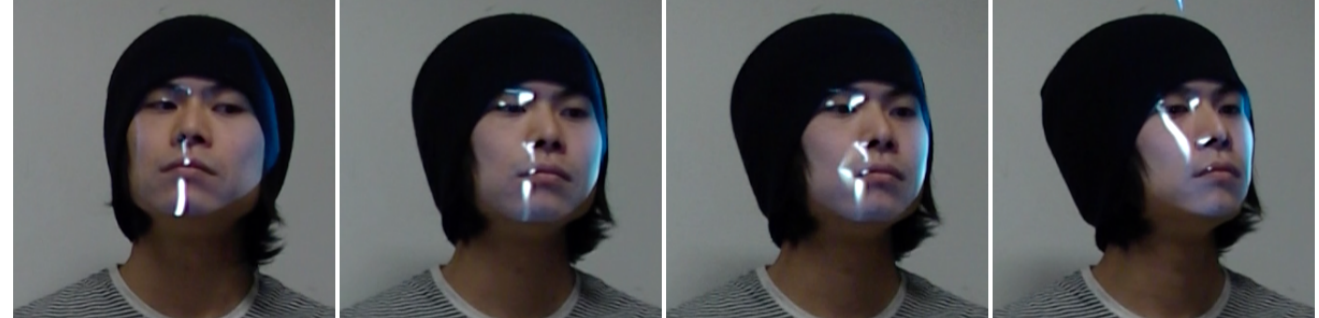
Fig. 6. Specular reflection shading. Highlights can be seen on the cheek and jaw, and move across the face according to the head orientation.